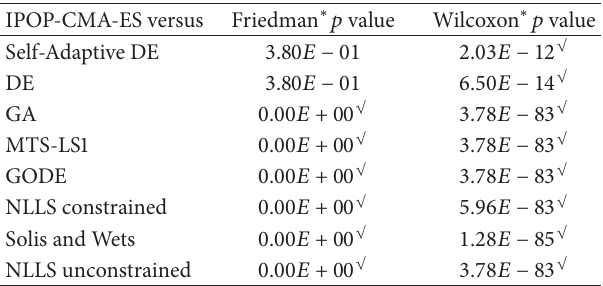
Table 7: Corrected 𝑝 values according to Holm’s method (IPOP- CMA-ES is the control algorithm) for the 4-by-4 degree polynomial rational function.